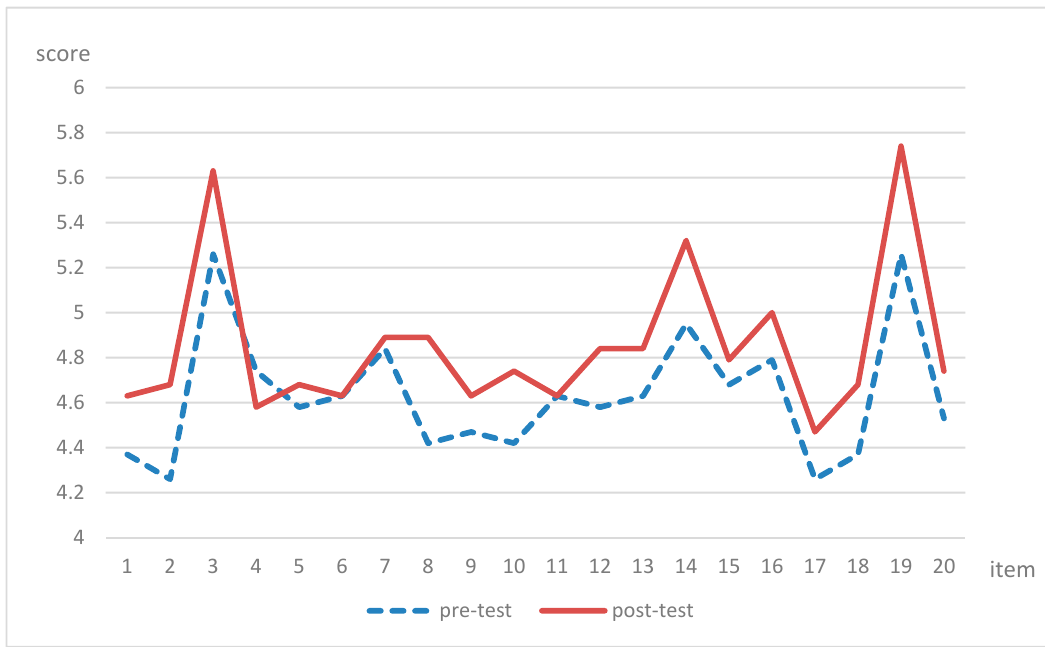
Figure 1. The average score for each item in the critical thinking scale (n = 19).